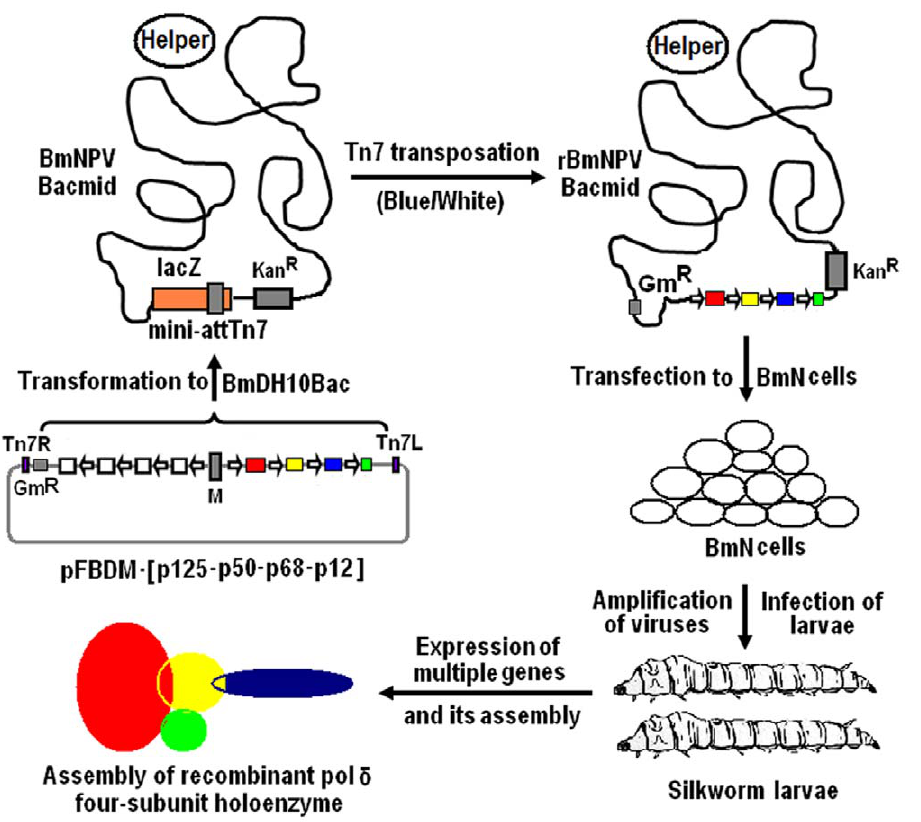
Figure 2. A schematic outline for generation of recombinant virus and its expression in silkworm larvae. The obtained recombinant transfer vector pFBDM-[p125-p50-p68-p12] was introduced into BmNPV bacmid DNA in BmDH10Bac E. coli cells. Colonies containing bacmid carrying integrated four-gene expression cassettes were identified by blue/white screening. Bacmid DNAs were isolated from selected white phenotypes. The recombinant BmNPV viruses were generated by the transfection of BmN insect cells with isolated bacmid DNAs. The four subunit pol d complex was then expressed and assembled in silkworm larvae by the infection of larvae with prepared recombinant viruses.